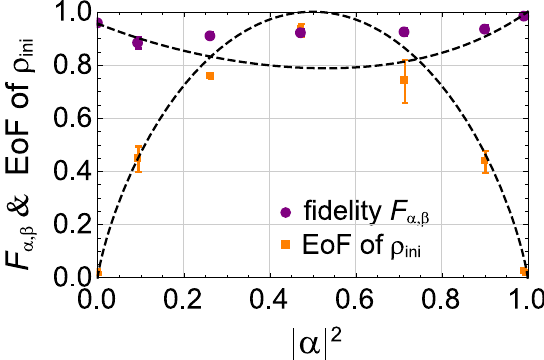
Figure 6. The observed fidelity F α , β between ρ ini and ρ fin (circle), and the EoF of ρ ini (square) for various values of | α | 2 which is estimated from the probabilities of the component |HH 〉 of ρ ini . A dashed curve for EoF is given by using the ideal state of | φ α , β 〉 . A dashed curve for the fidelity is given by the inner product between | φ α , β 〉 and the final state with considering the multiple emission events and the mode matching effect.